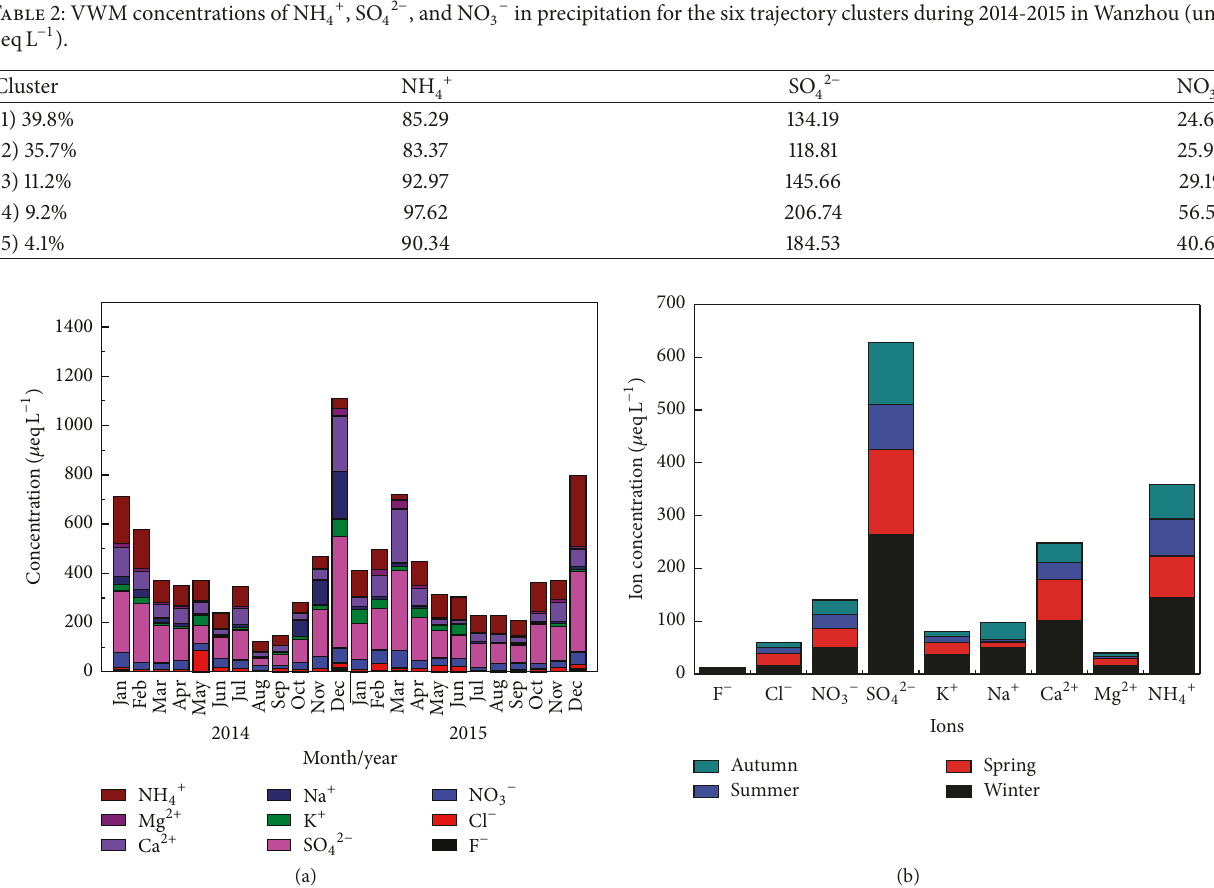
Figure 5: (a) Monthly variations and (b) seasonal variations in the VWM concentration of ions in the precipitation in Wanzhou.